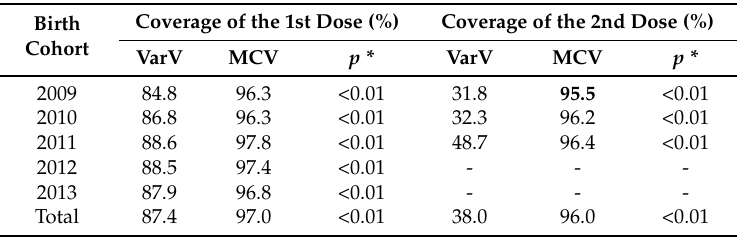
Table 5. Comparative assessment of vaccination coverage of VarV and MCV for children born from 2009 to 2013 in Zhejiang